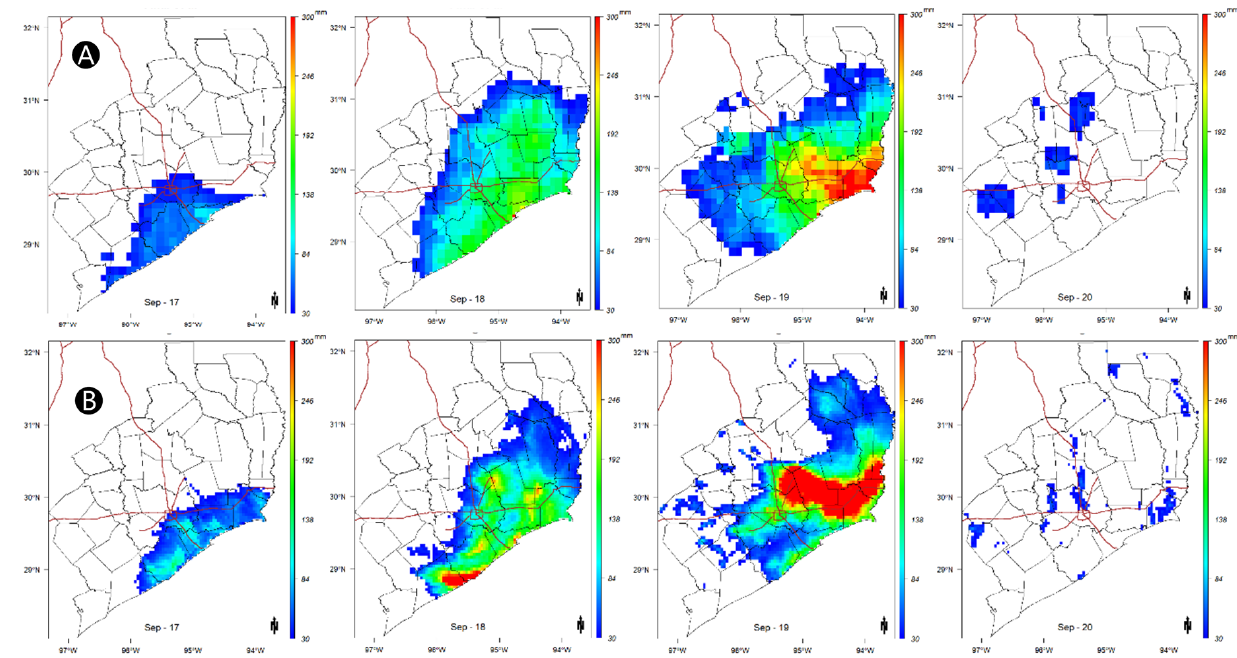
Figure 3. Evolution of the Tropical Storm Imelda after its landfall on 17 September 2019 (daily rainfall ≥30 mm are shown) and spatial pattern captured by ( A ) IMERG Final-run, ( B ) Stage-IV products.